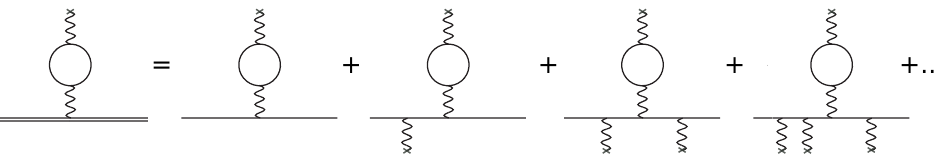
Figure 4 . The schematic diagrammatic expansion of the 1PR contribution to the self energy interactions with the background (cid:12)eld for crossed (cid:12)elds. Being linear in the coupling of the loop, there is only one low energy photon attached